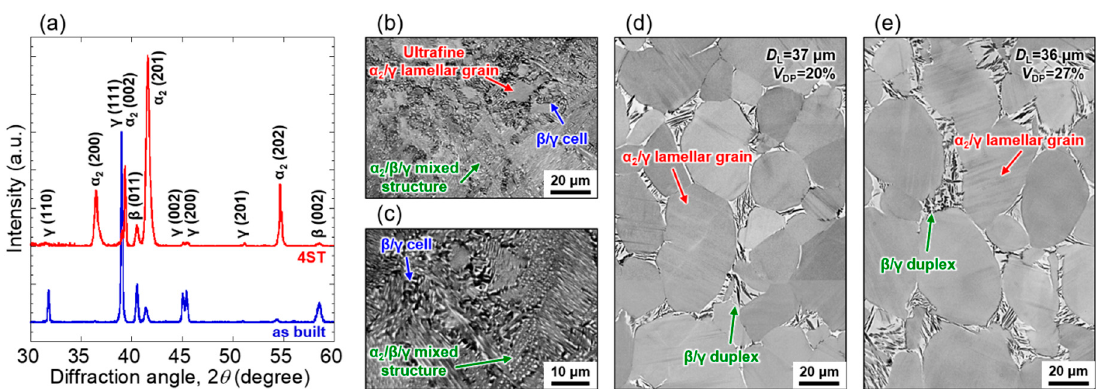
Figure 2. Typical XRD profiles of the as-built and 4ST rods ( a ) and SEM-BSE images of the as-built ( b ), ( c ), 2ST ( d ), and 4ST ( e ) rods. ( b ) Enlarged image of the area in the as-built rods containing the α 2 / β / γ mixed structure and the β / γ cell.